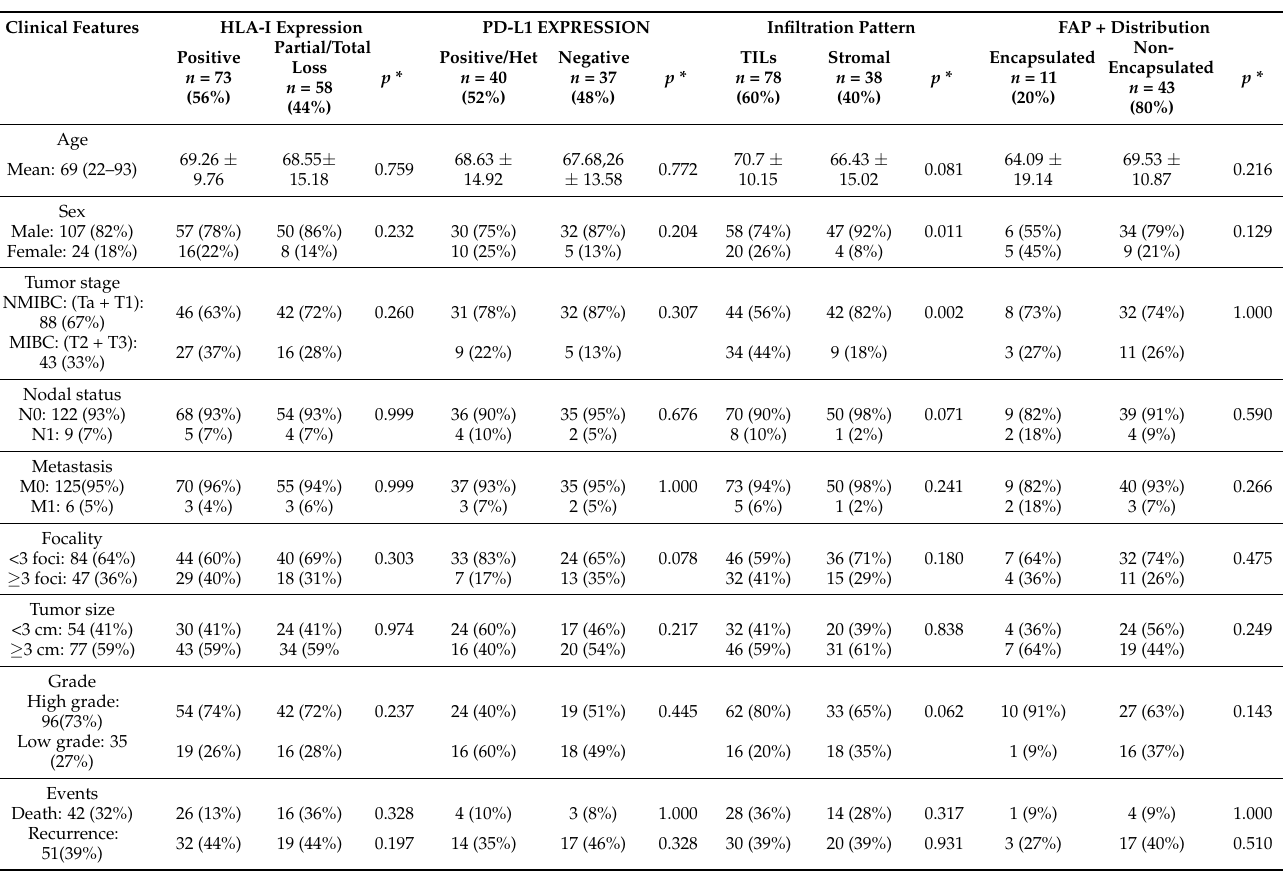
Table 1. Clinical Features of bladder cancer patients and tumor HLA class I and PD-L1 expression, infiltration pattern and tumor architecture with FAP+ cell